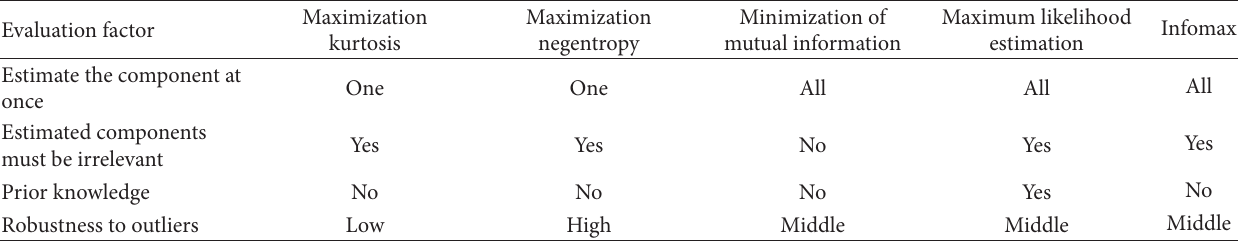
Table 1: Comparison of five objective